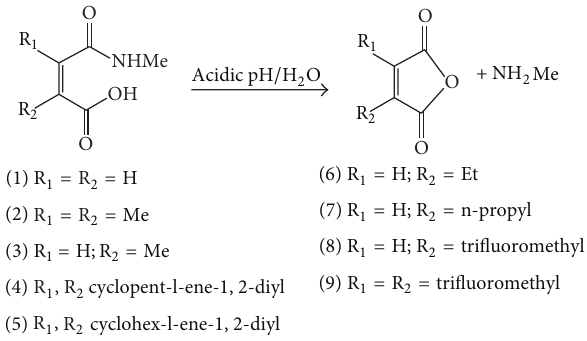
Figure 2: Acid-catalyzed hydrolysis for N-alkylmaleamic acids